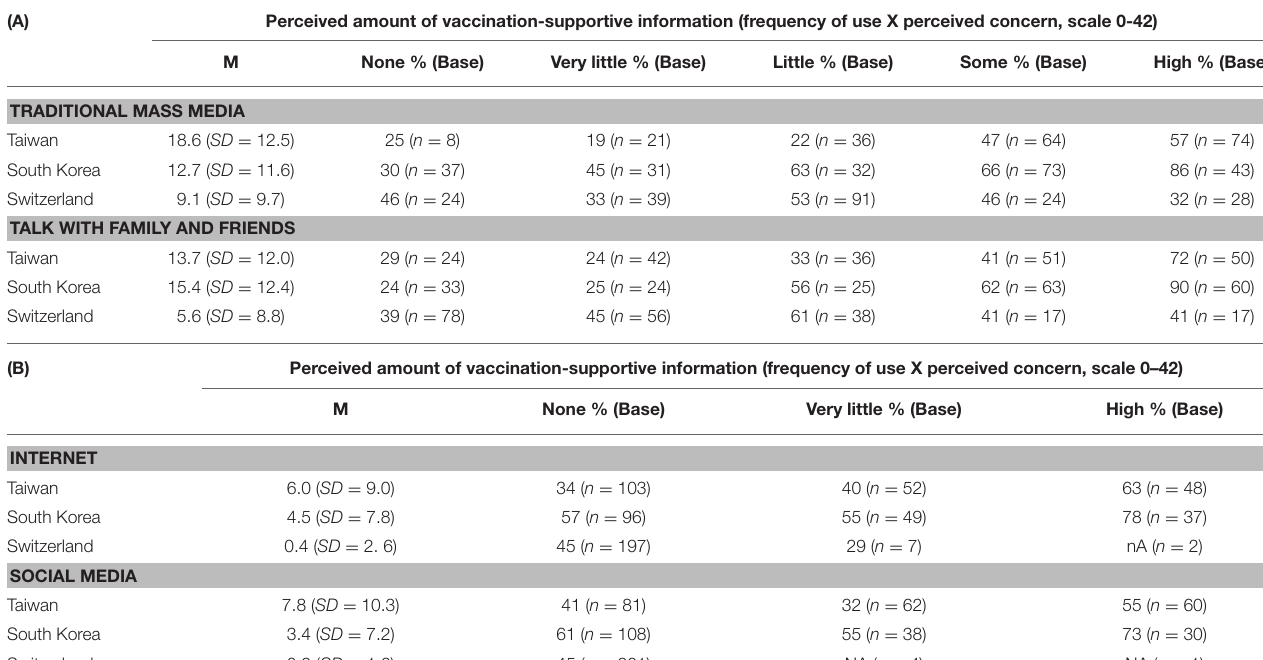
TABLE 1 | Percentage of respondents vaccinated by sources, country, and perceived amount of vaccination-supportive